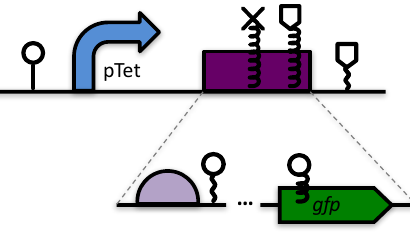
Figure 30: Detailed design of a promoter, in which the transcription start site is preceded by two operator sites where regulators bind, and the whole is flanked by insulators.